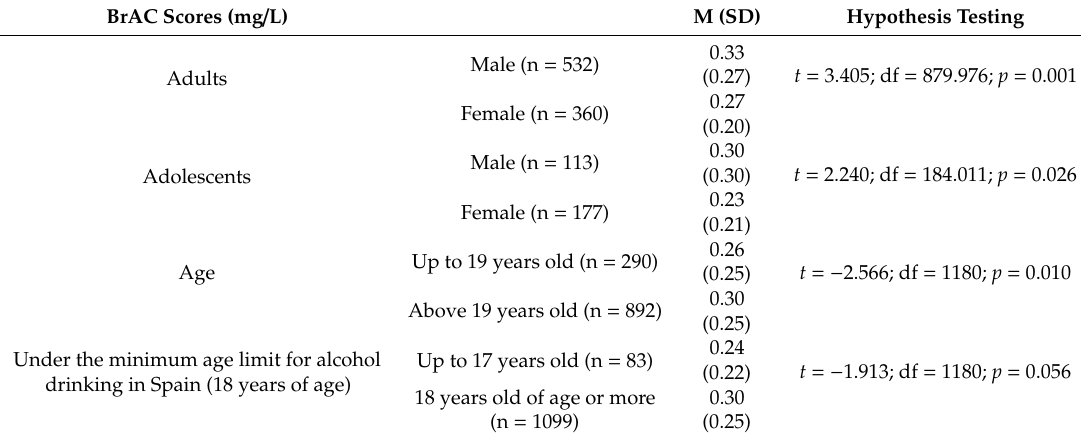
Table 4. Comparison of BrAC by gender and age (for participants with BrAC > 0).